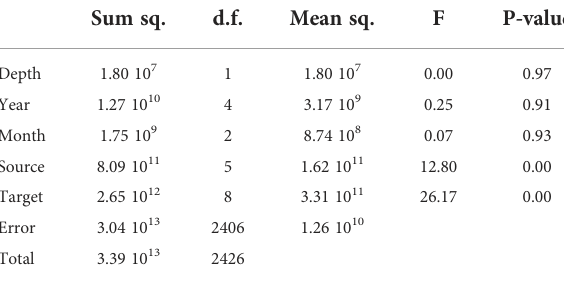
TABLE 1 Analysis of variance. Sq Square; d.f. degree of freedom. Sum sq.